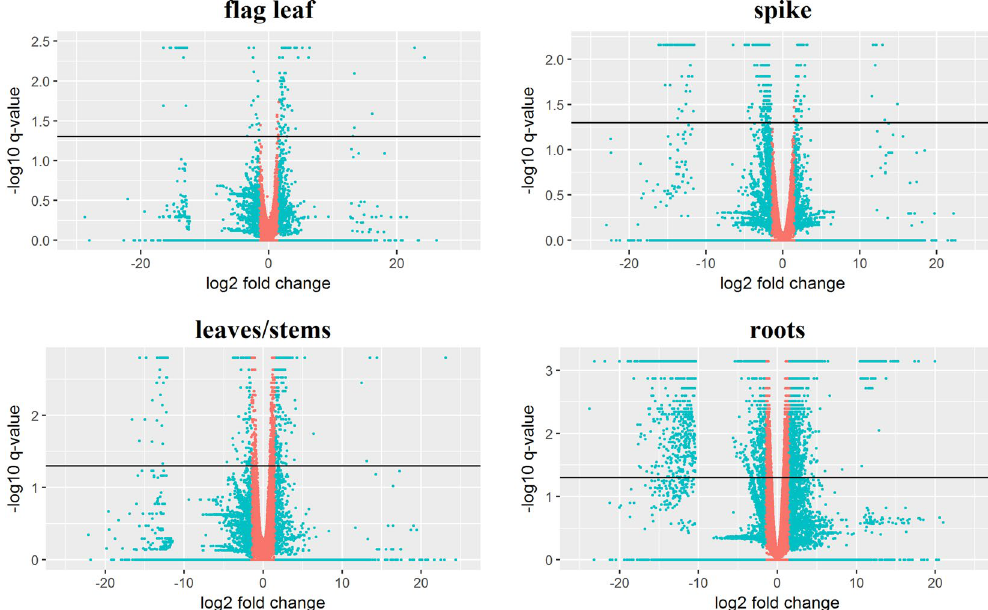
Figure 2. Volcano plot of the differentially expressed genes (DEGs) for each tissue investigated in this work. The y-axis corresponds to the mean expression value of − log10 (q-value), and the x- axis displays the log2 fold change value. The light blue dots represent up and downregulated DEGs, the pink dots denote not DEGs. The black bar indicates the q-value filtering.